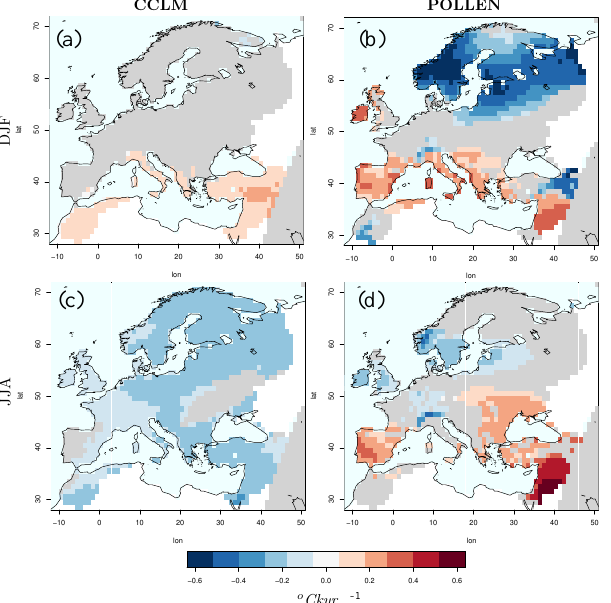
Figure 10. Canonical correlation pattern pairs of MSLP (left) and T2M (right) in Winter , calculated accordingly to the Barnett and Preisendorfer (1987) method. Each panel illustrates the percentage of variance explained by the patterns and the canonical correlation associated with the pair. The results are calculated for the mid-to- late Holocene, from 6000BP to pre-industrial times. Note that the MSLP has been obtained directly from the driving GCM, since the window of interest lies outside the RCM domain. For both the vari- ables the analysis has been conducted on the standardised anoma- lies with respect to the pre-industrial period. Red (blue) areas in- dicate positive (negative) correlations, for each grid point, between the data and the corresponding canonical score